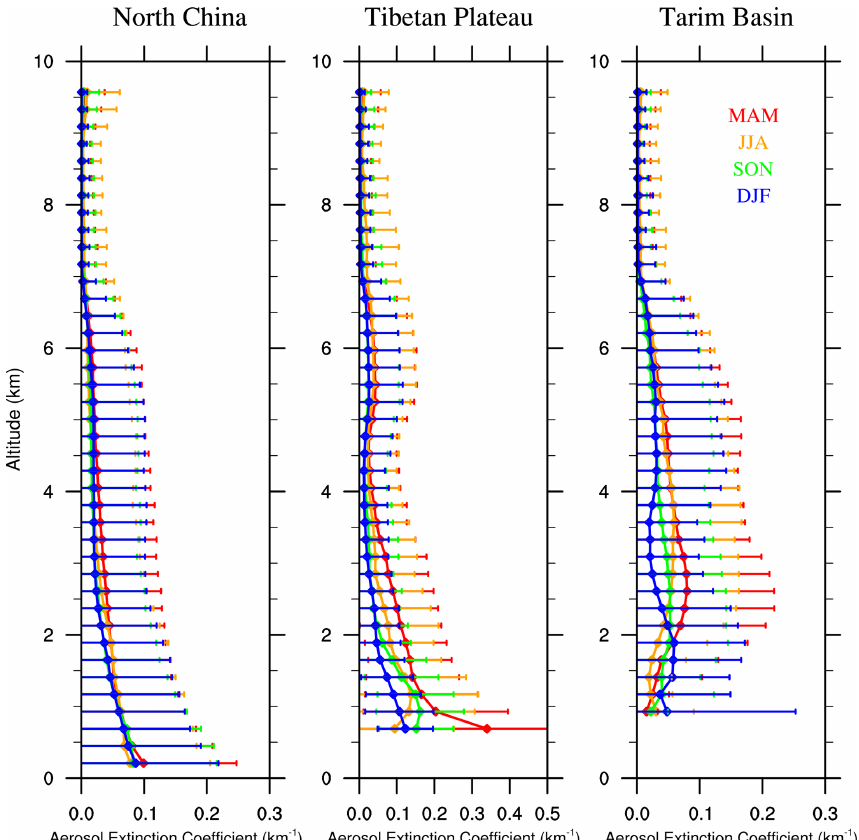
Figure 6. Vertical profiles of the 1064nm aerosol extinction coefficients (km − 1 ) observed from CATS by season over the three regions. Horizontal lines correspond to the standard deviation of the intraseasonal aerosol